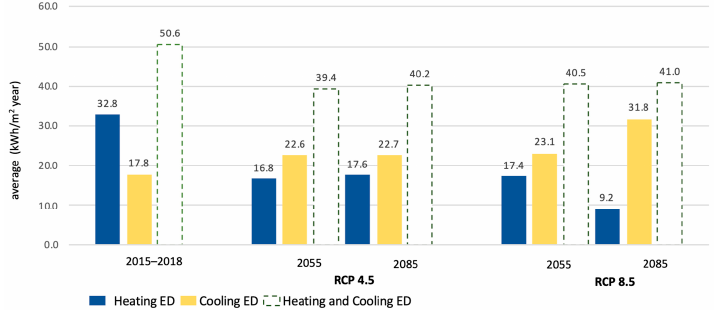
Figure 7. Dynamics of changes in the average of heating and cooling energy demand for the RCP4.5 and RCP8.5 scenarios by 77 stations. Table 5. Dynamics of changes in energy demand between significant seasons.